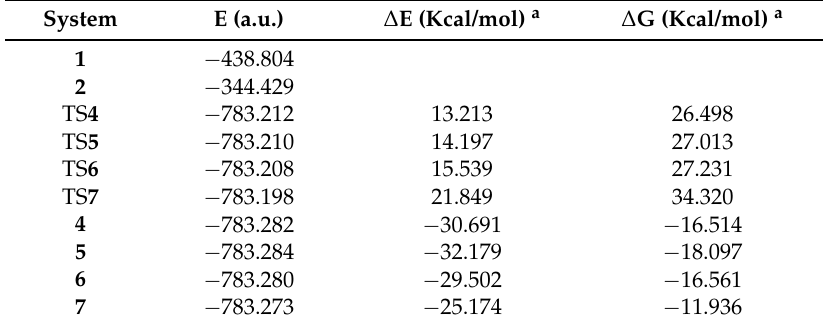
Figure 3. Energy profiles, in kcal/mol for the two pathways of the CA reactions (red; 4 , violet 5 , brown 6 and black 7 ).